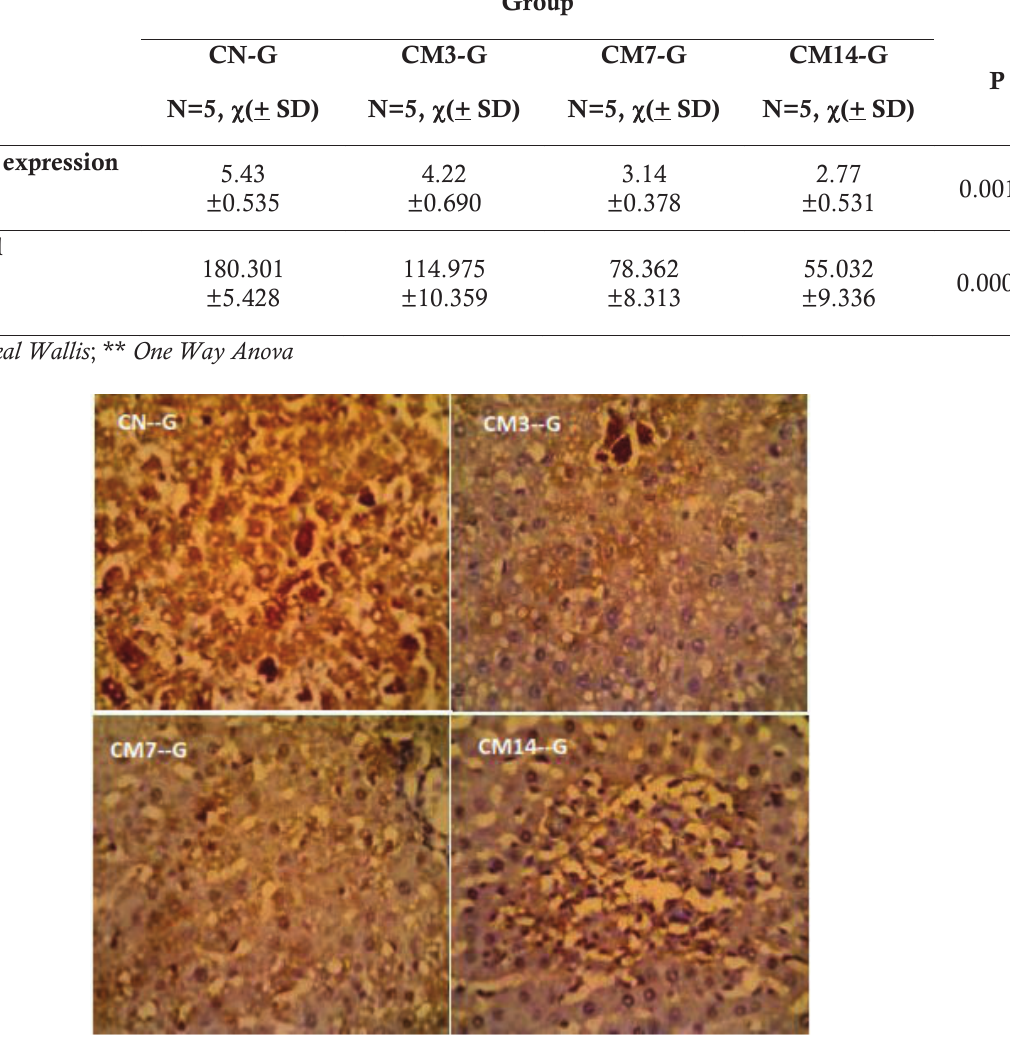
Figure 1. Caspase 3 expression in group CN-G; CM3-G; CM7-G; and CM14-G. The brown color indicated the caspase 3 expression expression. positive